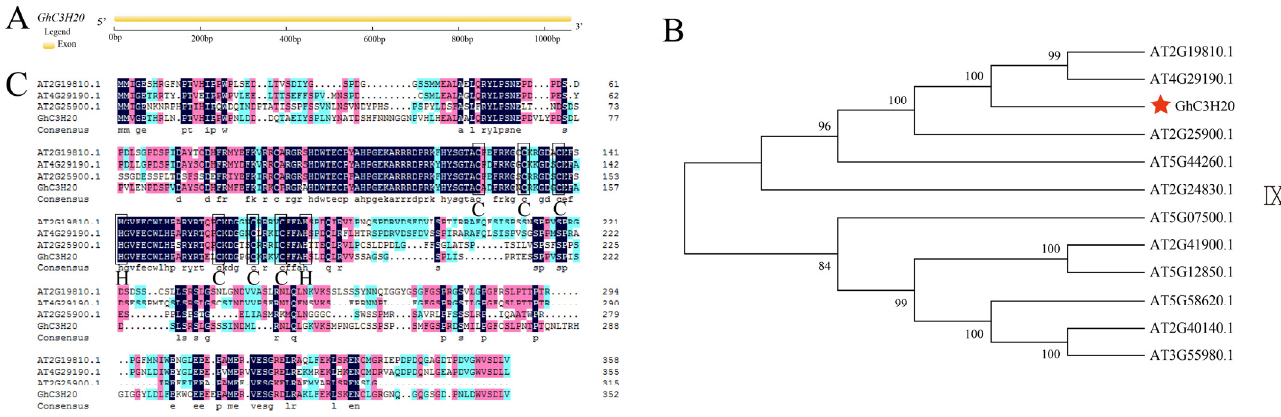
Figure 1. GhC3H20 gene structure, sequence alignment, and phylogenetic analysis. ( A ) Gene structure of GhC3H20 . ( B ) Phylogenetic analysis of GhC3H20 and CCCH zinc-finger family group IX members in Arabidopsis thaliana . ( C ) Protein sequence alignments of GhC3H20 with AT2G19810, AT4G29190, and AT2G25900. Note: CCCH represents the C3H-type motif. The colored regions represent conserved amino acid sequences. The red star represents GhC3H20 gene.